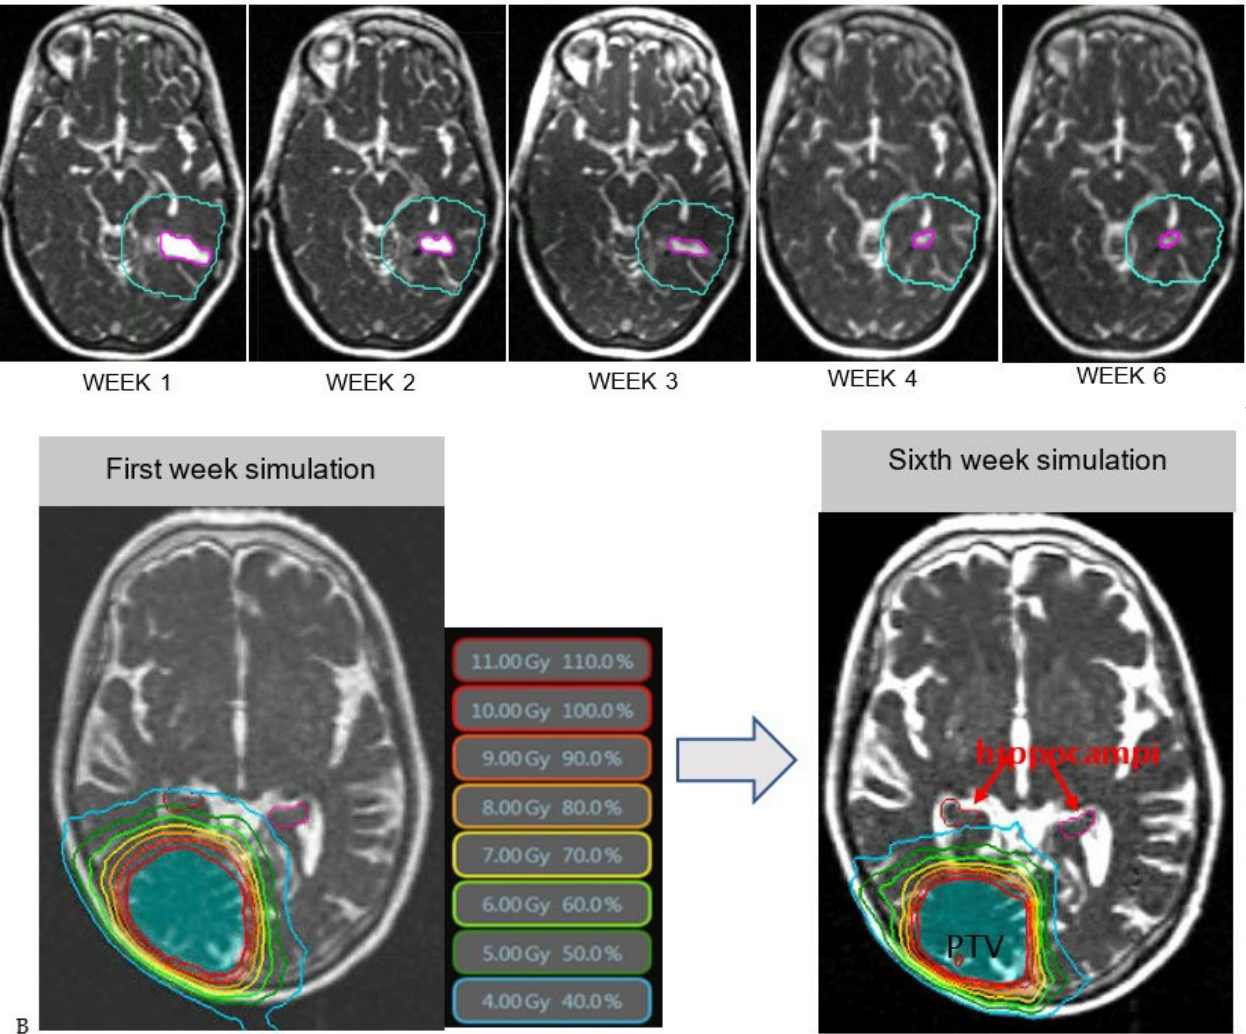
Figure 3. ( A ): Resection cavity shrinkage visualized on MRI–Linac: T2-weighted bSSFP treatment set-up scans This shows the PTV and RC volume trending downwards as the weeks progressed. Week 1: Volume of RC is 3.0 mL and mean dose to brain is 3.3 Gy. Week 2: Volume of RC is 1.3 mL and dose to brain is 2.7 Gy. Week 3: Volume of RC is 0.8 mL and dose to brain is 2.7 Gy. Week 4: Volume of RC is 0.6 mL and dose to brain is 2.5 Gy. Week 6: Volume of RC is 0.5 mL and dose to